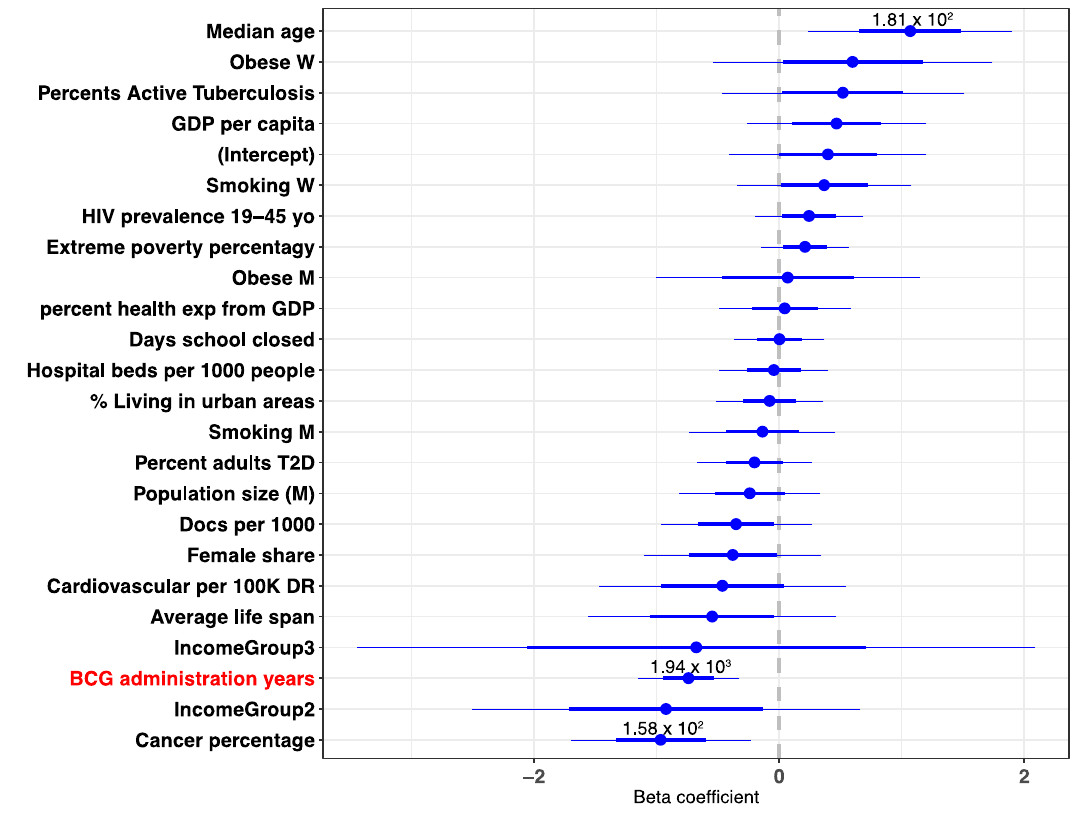
Figure 4. Multivariable analysis of country-centric quantitative data. Beta coefficients of the normalized multivariable linear regression for DPM at day 20 are shown. Blue lines represent the coefficients’ 95% confidence intervals. p -values are shown for all variables with p -value < 0.1.